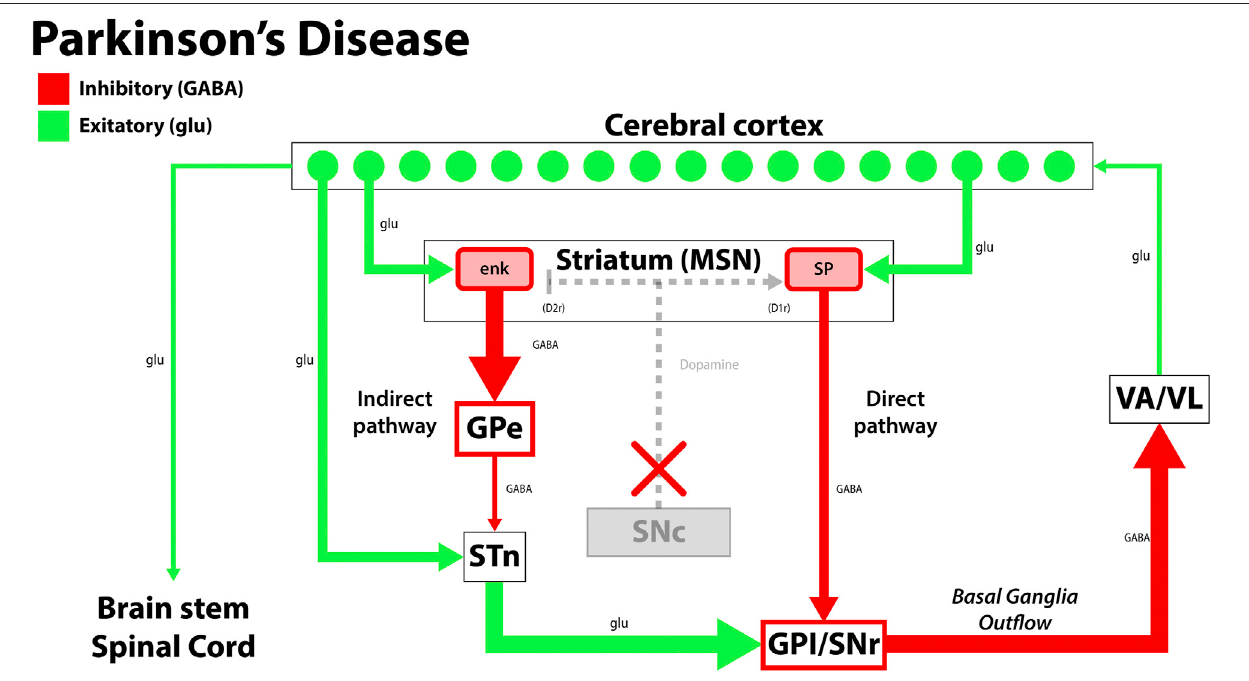
FIGURE 1 | The disruption in the functional circuit in Parkinson ’ s disease. In PD, loss of the dopaminergic neurons of the substantia nigra pars compacta (SNc) leads to increased output by the indirect pathway and less motor output. The loss of dopaminergic neurons also impacts the direct pathway, increasing the circuit ’ s inhibition on the thalamus (VA/VL). Green arrows signify glutamatergic excitatory neurons and red arrows signify GABA expressing inhibitory neurons. enk, enkephalin; SP,SubstanceP;GPe,globuspallidus, externalsegment;GPi,globuspallidus,internalsegment;SNc,substantianigraparscompacta; SNr,substantianigrapars reticulata; STN, subthalamic nucleus; VA/VL, ventral anterior/ventral lateral nucleus of the thalamus; D1r, D1 dopaminergic Gs coupled receptor; D2r dopaminergic Gi coupled receptor. Adapted from (McGregor and Nelson,